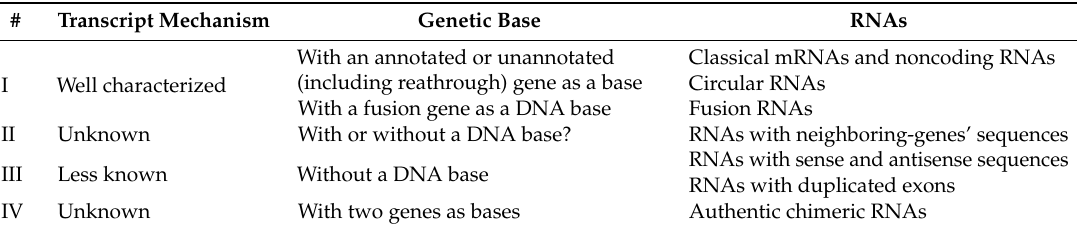
Table 2. Classification of long mature